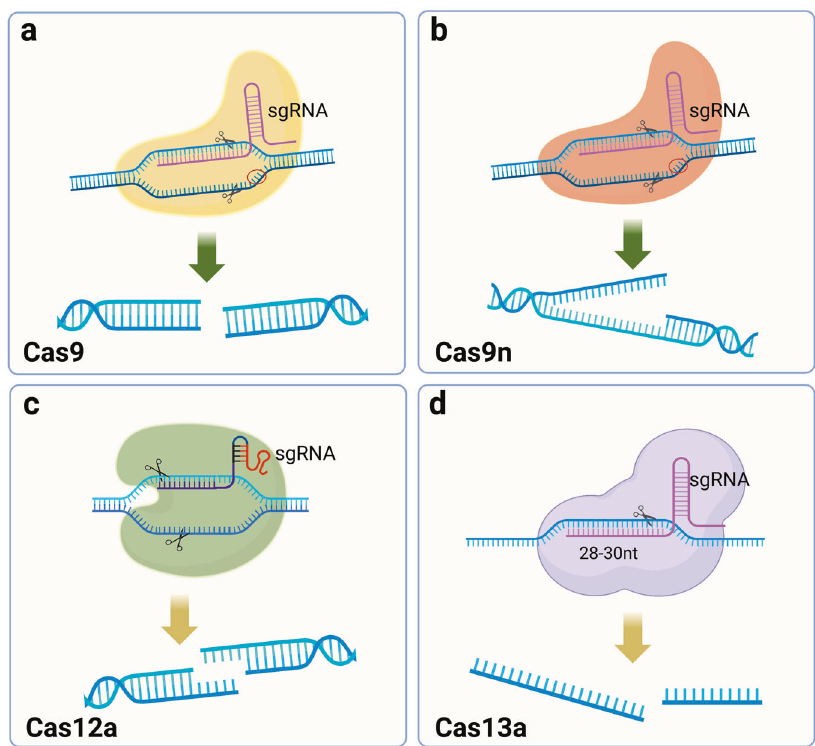
Fig. 2 Schematic diagram of DNA strand cleavage tools. a Cas9 cleaves DNA double strands to form fl at ends. b Cas9 nickase (Cas9n) cleaves the single DNA strand. c Cas12a cuts DNA double strands to form sticky ends. d Cas13a recognizes and cleaves RNA strands. (Figure was created with